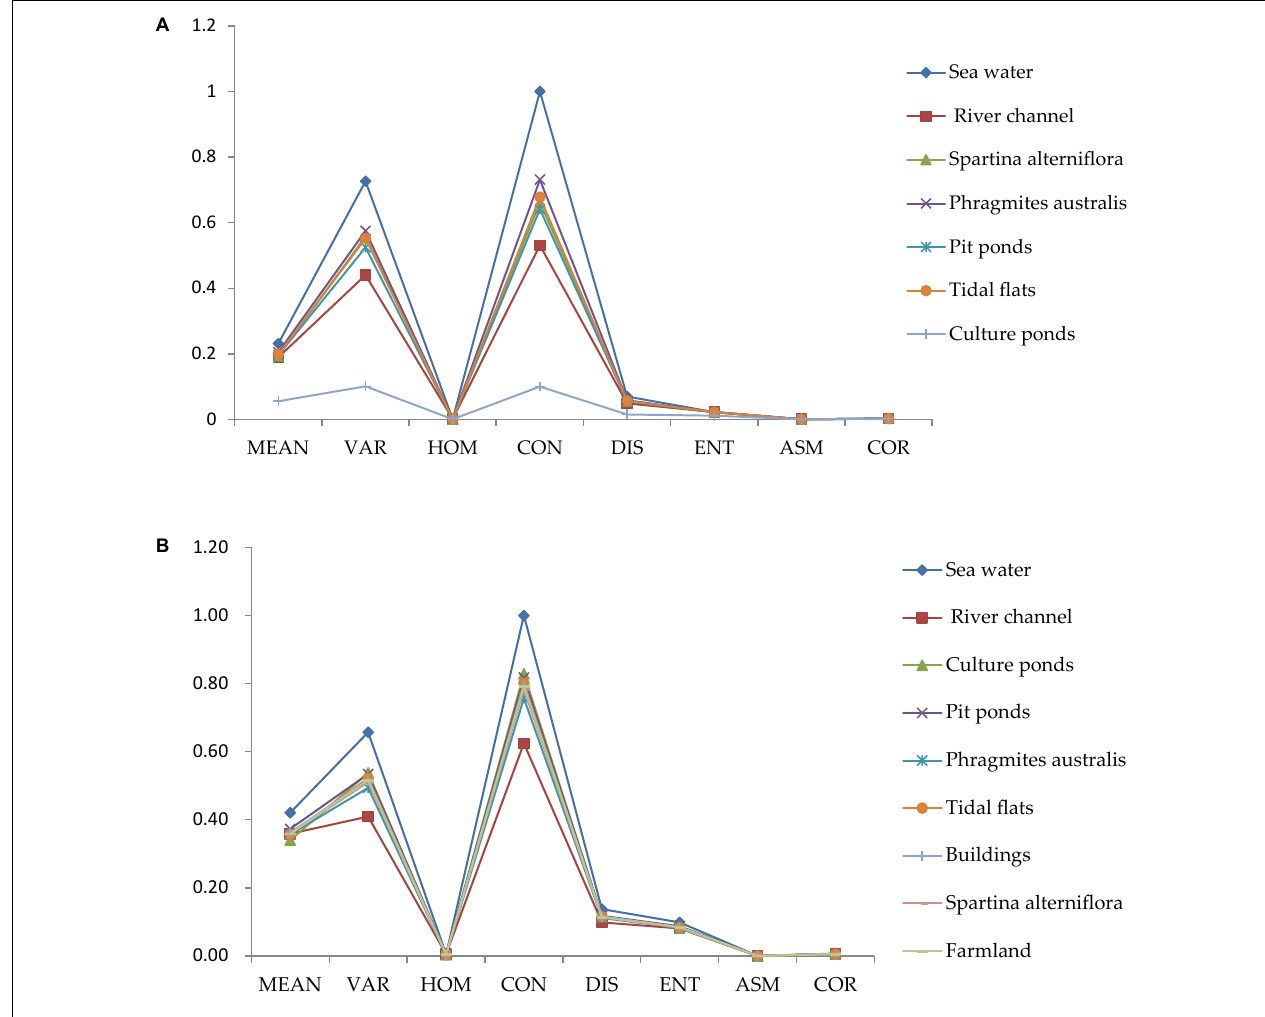
FIGURE 7 | Statistics of the texture feature parameters. (A) Is the data of October 2017, (B) is the data of November 2018.